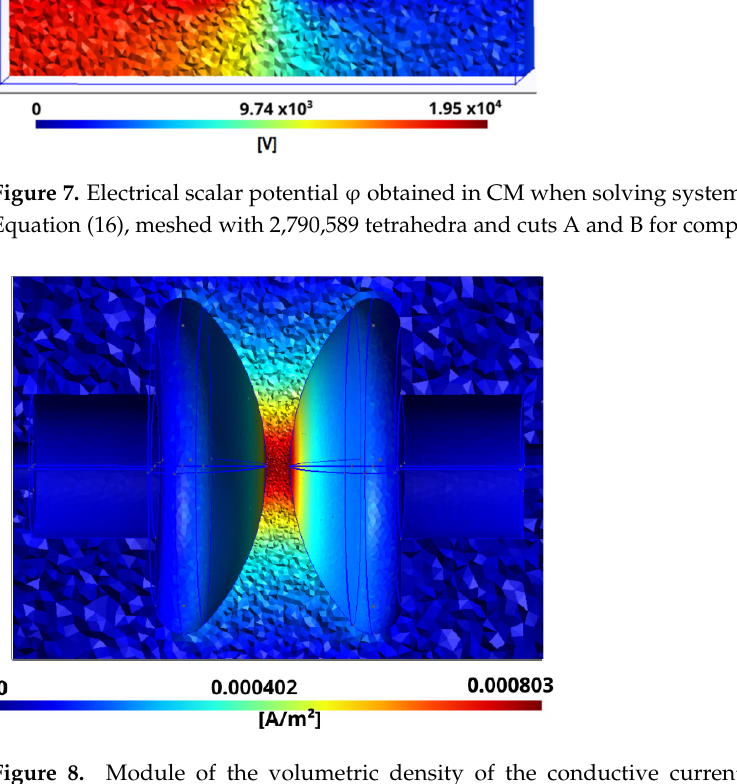
Figure 8. Module of the volumetric density of the conductive current 𝐽⃗ (cid:3033) corresponding to Equation (1).